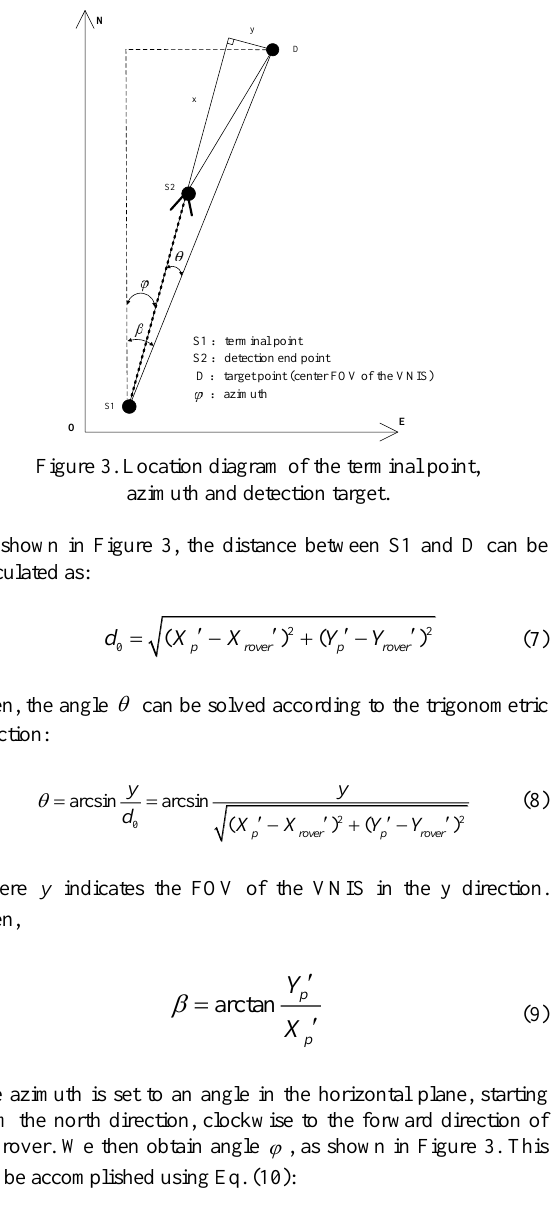
Figure 4. Flowchart of the prediction the FOV of the VINS in the Hazcam